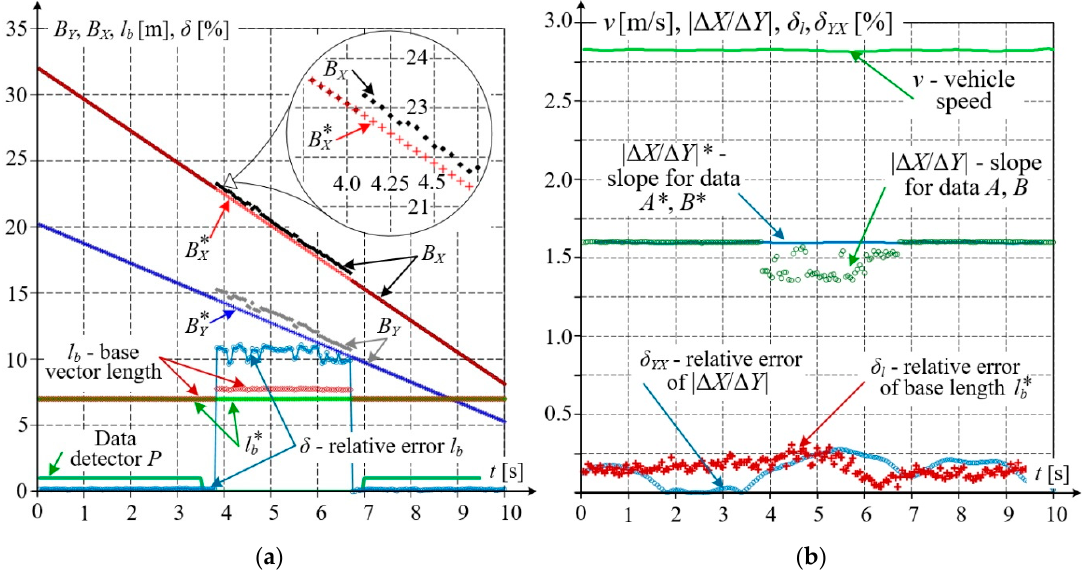
Figure 14. Results of filtering based on Savitzky–Golay and Whittaker algorithms: ( a ) waveform of data detector, correction of receiver B results to B *, base vector length and relative error; ( b ) speed, base vector slope, and relative error.